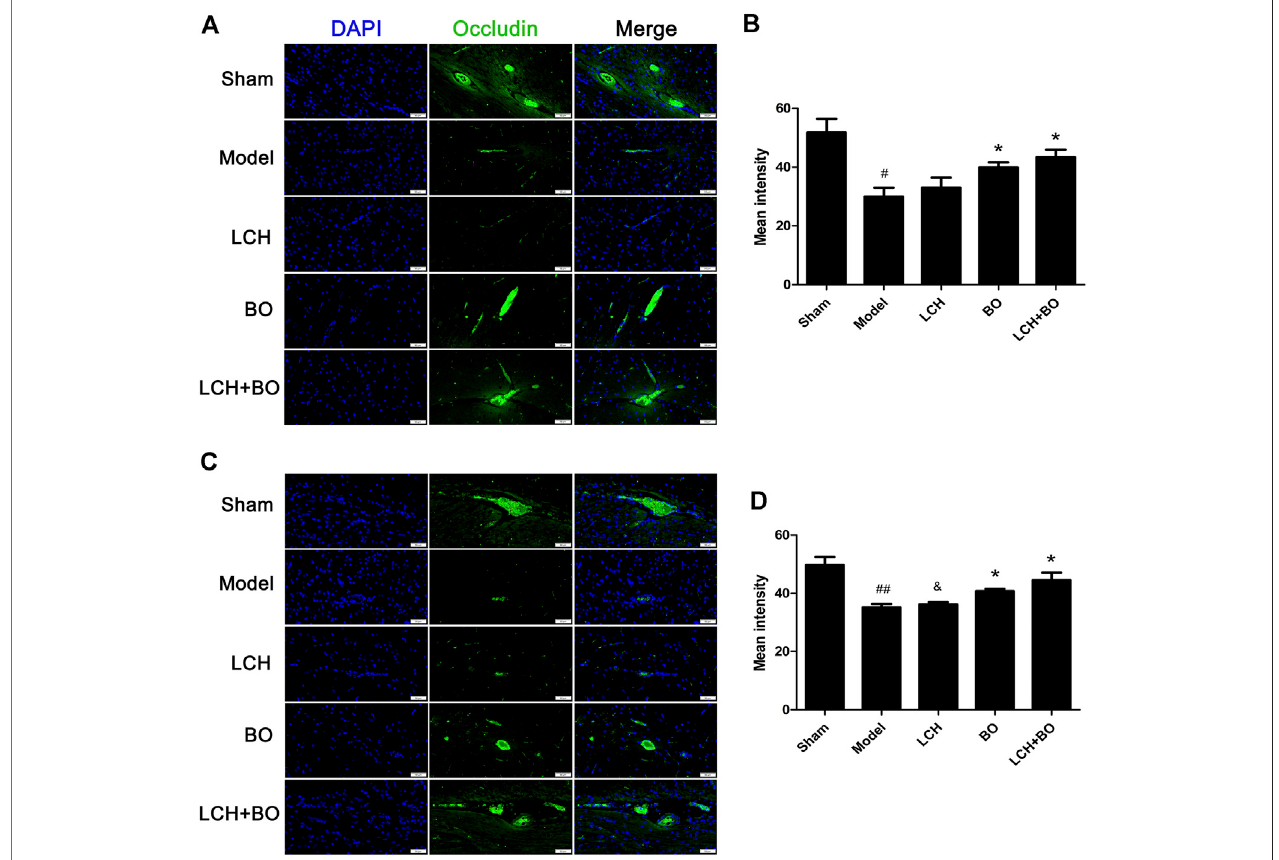
FIGURE 12 | Expressions of occludin within DG and SVZ of MCAO rats. (A) Representative immunostaining images of occludin in the DG area. (B) The results of average fl uorescence intensities of occludin in the DG area ( n (cid:1) 3). (C) Representative immunostaining images of occludin in the SVZ area. (D) The results of average fl uorescence intensities of occludin in the SVZ area ( n (cid:1) 3). # p < 0.05, ## p < 0.01 compared to the sham group; * p < 0.05 compared to the model group; & p < 0.05 compared to the LCH + BO group.